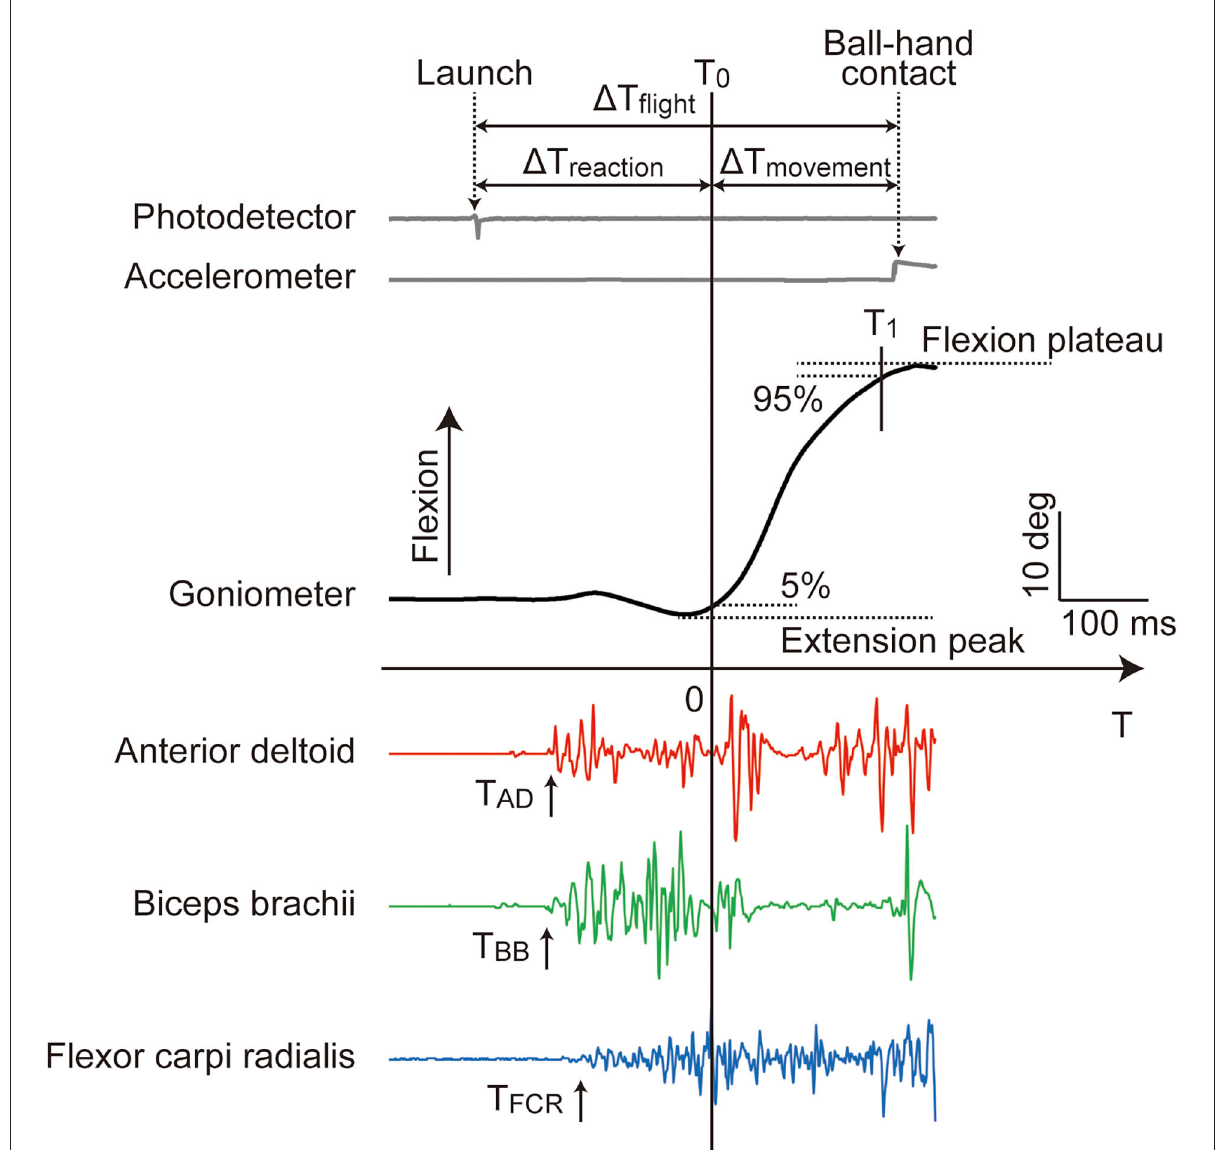
FIGURE3 Typical profile of the analog data recorded in the PR experiment. T 0 (T = 0) and T 1 were determined by the 5 and 95% thresholds of the shoulder flexion total amplitude from the extension peak to the flextion plateau, respectively. All of the EMG onsets (T AD , T BB , and T FCR ) appeared before T 0 . The ball flight time ( 1 T flight ), arm reaction time ( 1 T reaction ), and arm movement time ( 1 T movement ) were elapsed time defined as shown. The shoulder flexion velocity ( ω flexion ) was calculated as the average angular velocity over 1 T movement . Among these variables, 1 T flight and 1 T reaction were not comparable between the PR and VR experiments (see main